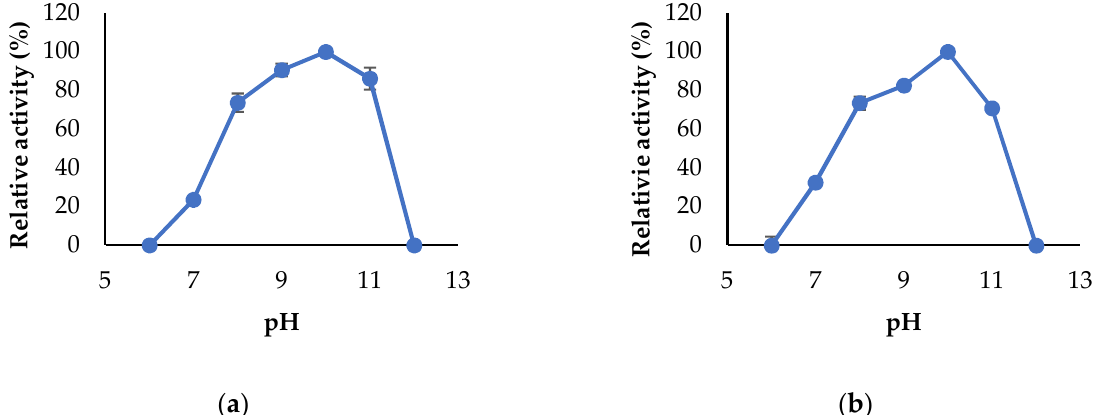
Figure 5. Optimum pH of Est2L ( a ) and Est4L ( b ). Enzyme activities were measured by a continuous method at each designated pH.